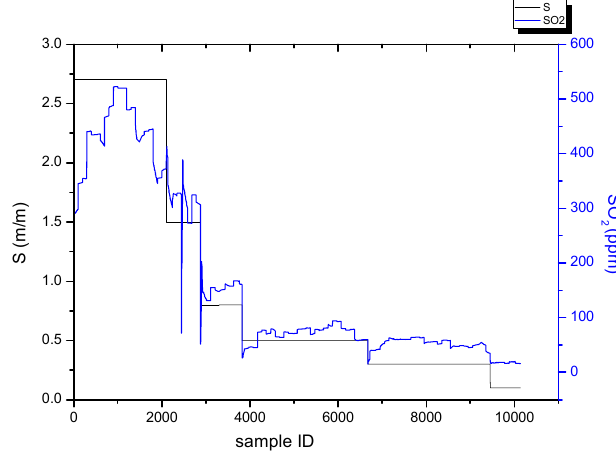
Figure 4. Changes in SO 2 concentration and sulfur content with time.